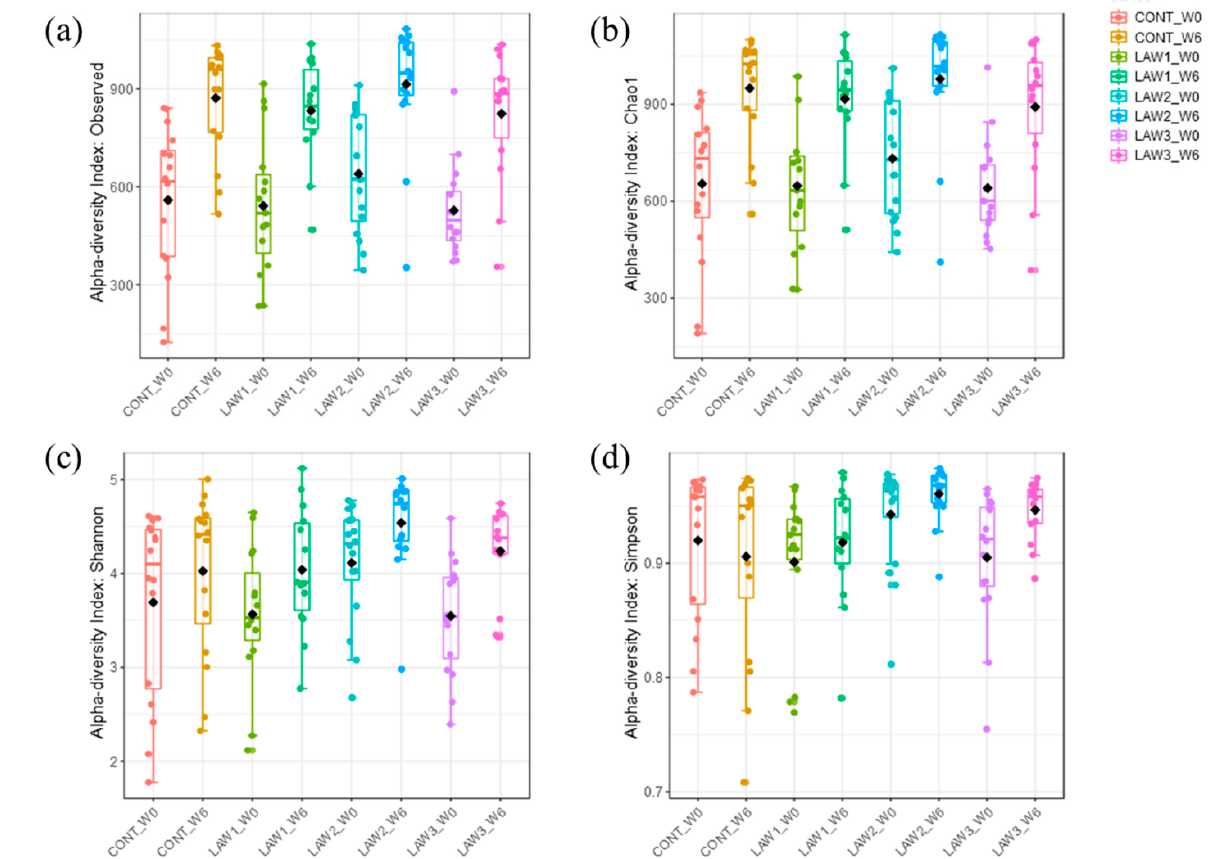
Figure 1. Box plots showing the alpha diversity indices in gut microbiomes of pigs orally vaccinated with Lawsonia intracellularis vaccine. Species richness were measured using ( a ) number of observed OTUs and ( b ) Chao1 diversity index. Species evenness and diversity were measured using ( c ) Shannon and ( d ) Simpson diversity indices. Boxes represent the interquartile range (IQR) between the 25th and 75th percentile, and the horizontal line inside the box denotes the median value. Whiskers represent the lowest and highest values within 1.5 times from the 25th and 75th quartiles, respectively. Boxes are colored according to the treatment group and time points as shown in the legend. W0 and W6 denote week 0 and week 6, respectively.